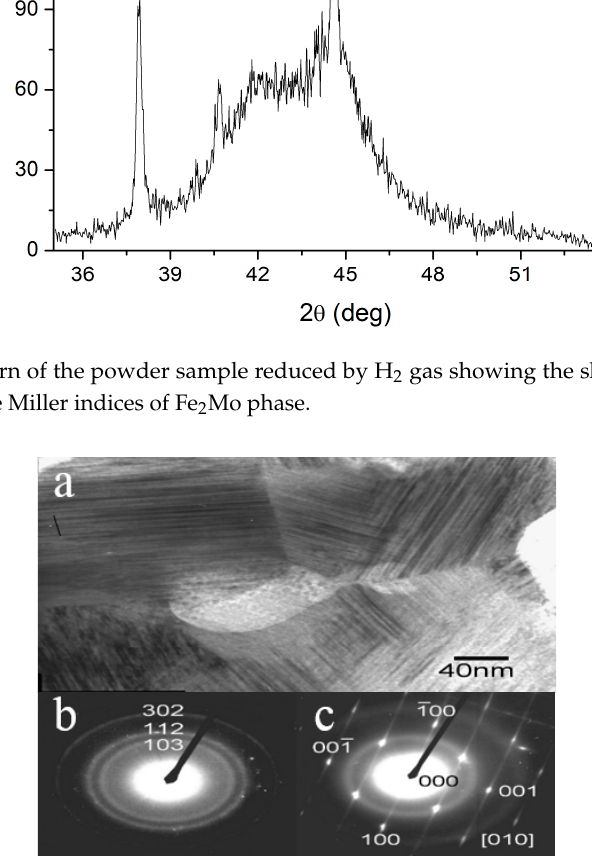
Figure 7. TEM micrographs of a Fe 2 Mo pellet pressed at 1 GPa showing: ( a ) domains of different orientations with perfect coherency at the particle interface; ( b ) SAD pattern showing microcrystalline structure; and ( c ) SAD pattern showing satellite reflection superimposed on microcrystalline pattern of Fe 2 Mo [9].